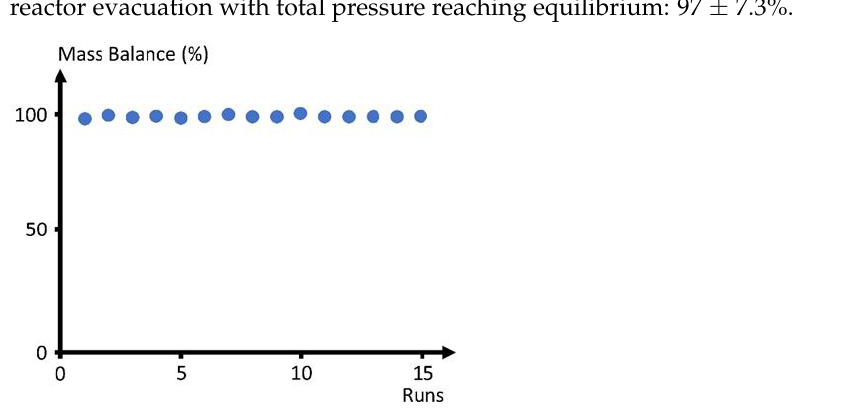
Figure A1. Inert % Mass Balances for 15 Catalytic Cracking Runs of 1, 3, 5-TIPB Using the Method Described in Appendix A. Condition 3, Standard Deviation: ±0.5%.